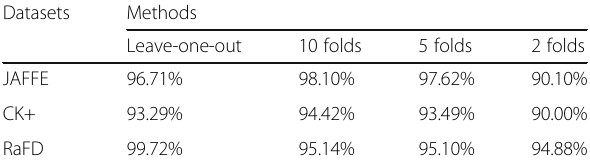
Table 4 Proposed accuracy methods using different folds Table 2 Proposed accuracy method using leave-one-out on the